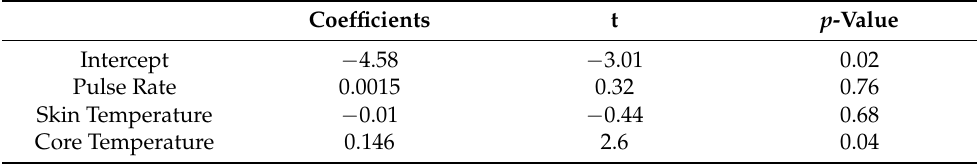
Table 2. The logistic regression parameters of operation error rate vs. core temperature.